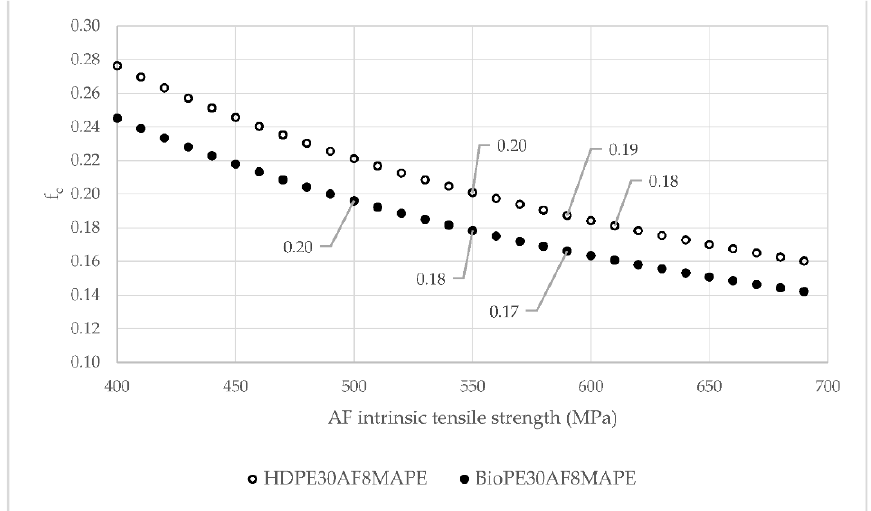
Figure 7. Evolution of the coupling factor of HDPE- and BioPE-based composites against Fiber Tensile Strength Factor.